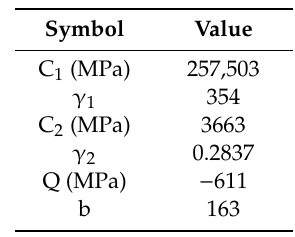
Figure 11. Transferability of method: ( a ) indentation of 38 HRC at 75 N; ( b ) prediction of stress–strain hysteresis of 38 HRC. Table 2. Identified material parameters for 50CrMo4 (38 HRC) after fitting of force–displacement at 75 N force